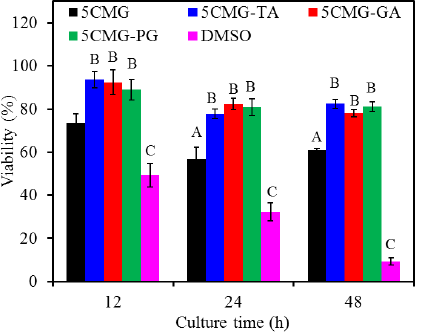
Figure 11. Cytotoxicity of various samples seeded with L929 cells at various time points. At the same cell culture time, different capital letters represented significant differences at p < 0.05.